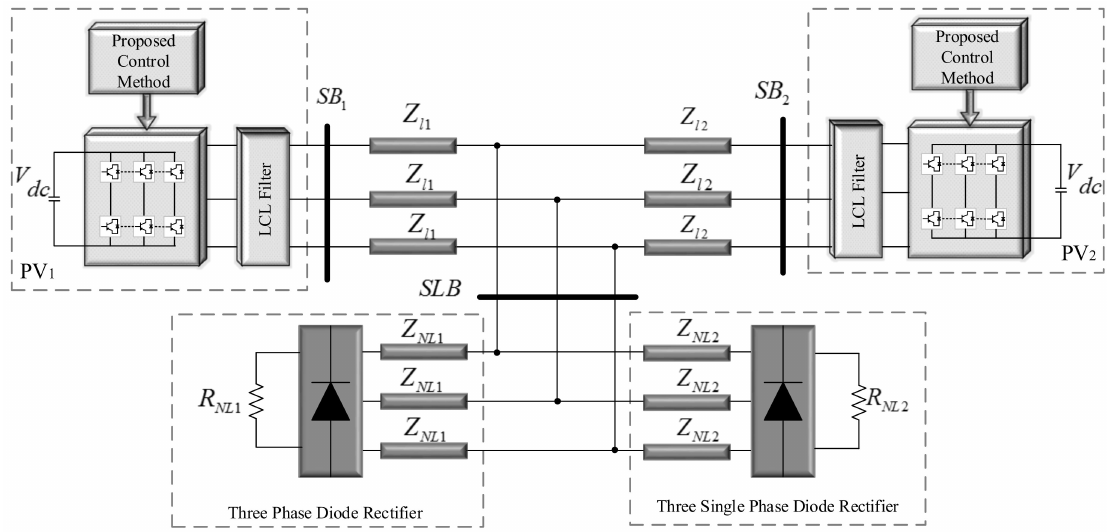
Figure 5. Structure of the microgrid (MG) used for